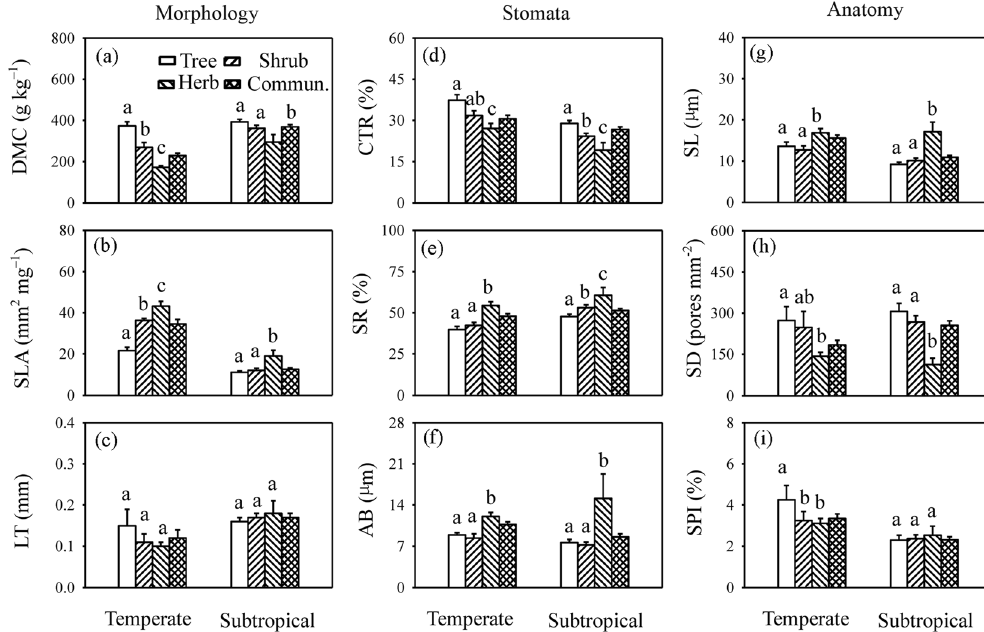
Figure 1. Differences in leaf traits between functional groups in temperate and subtropical forests. DMC, dry matter content; SLA, specific leaf area; LT, leaf thickness; SL, stomatal pore length; SD, stomatal density; SPI, stomatal area index; CTR, cell tense ratio; SR, spongy tissue ratio; AB, abaxial cell thickness. Data are shown as average ± SE. The same letters indicate no significant difference at the 0.05 level.